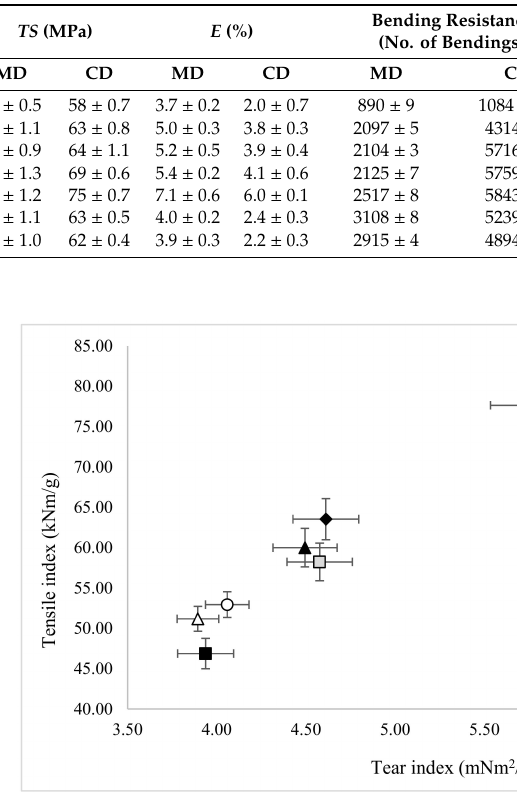
Figure 3. Tensile and tear indices for the uncoated (U), chitosan and zein coated (CZ), blend zein and rosemary oil coated (ZR), blend chitosan and rosemary oil coated (CR), chitosan and blend zein and rosemary oil coated (CZR) paper, pure chitosan in one layer coated (C) and the pure zein in one layer coated (Z) paper in the MD direction.